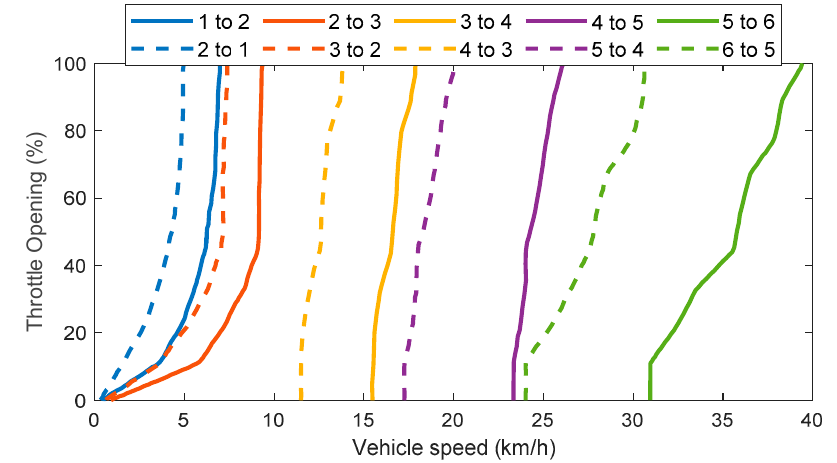
Figure 5. The traditional two-parameter economical shift strategy.